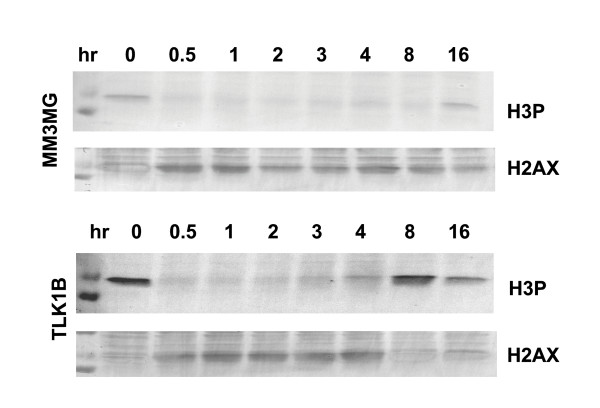
Phosphorylation of H3 and H2AX after irradiation. MM3MG and MM3MG over-expressing TLK1B cells were grown to 80% confluence prior to gamma-radiation (10 Gy). Cells were harvested at different times (0 h, 30 min, 1 h, 2 h, 4 h, 8 h and 16 h) after irradiation and lysed in RIPA buffer. Equal amount of protein of each sample was loaded on a 15% SDS-PAGE gel and electrophoresed. Blots were probed with phospho-Histone H3 (Ser-10) antibody, or phospho-Histone H2AX (Ser-139) antibody (Upstate Cell Signaling). Equal loading of proteins was confirmed by staining the blots with Ponceau S prior to processing. These blots are representative of two separate experiments.